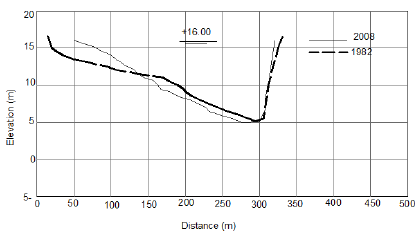
Figure 11. Cross section No.2